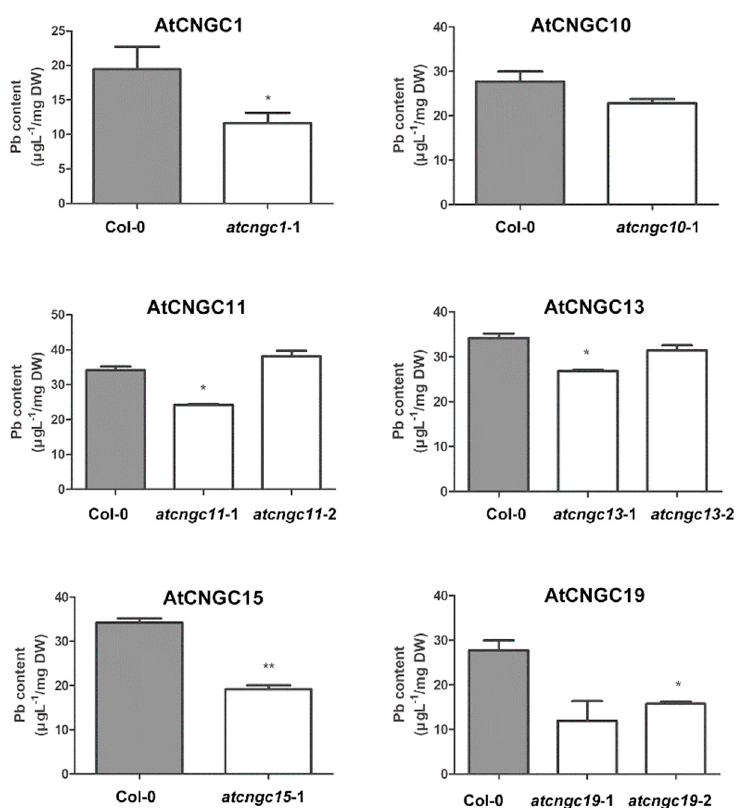
Figure 4. Pb 2+ content in Arabidopsis plants grown on an agar medium with Pb 2+ . All of the seedlings used to measure primary root growth in three replicated experiments were combined and extracted in 60% ( v / v ) HNO 3 . Elemental analysis was conducted utilizing an ICP-MS System. Data presented represent the mean ± SEM ( n = 3). T-tests were conducted to compare the concentration of each element in cngc mutants vs. wild-type plants. * and ** symbols indicate significant differences at p > 0.05 and p > 0.01,